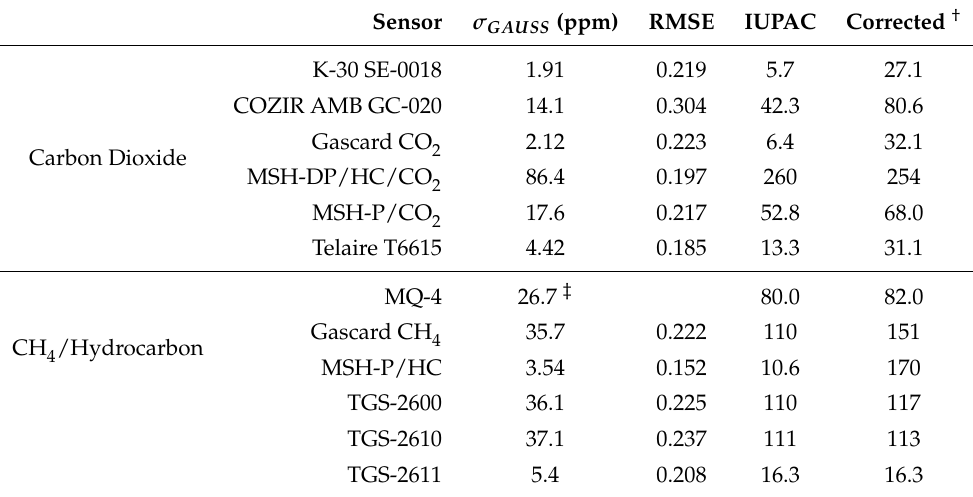
Table 2. The first two numbered are the computed standard deviation in ppm of Gaussian fitted probability distributions and root-mean-squared error in the fit. The next two numbers are the computed International Union of Applied Chemistry (IUPAC) (3 σ GAUSS ) and calibration uncertainty corrected Limits of Detections in